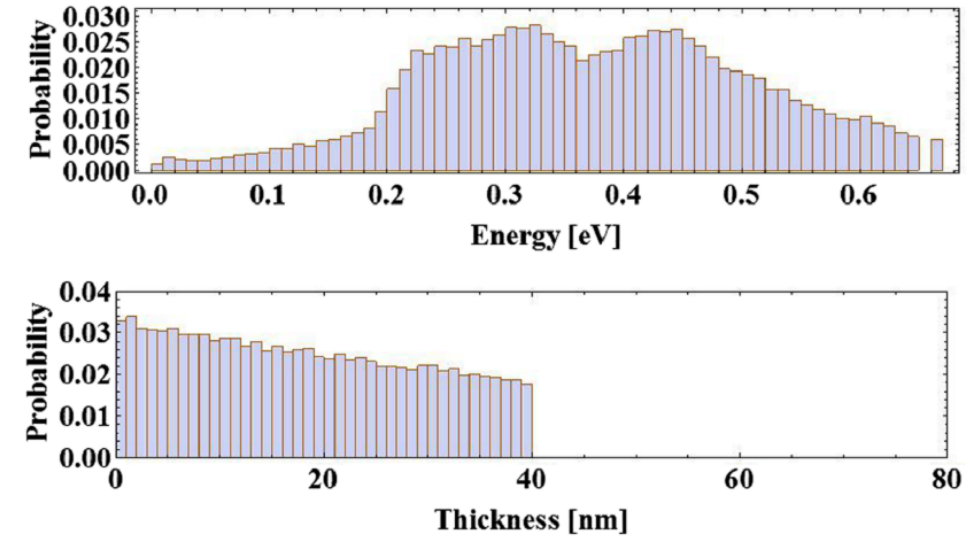
Figure 10. ( top ) The histogram of the electron-energy distribution in the conduction band excited by 2.32 eV laser photons at room temperature. The Y-axis is the probability distribution of electrons at different energies. ( bottom ) The longitudinal distribution of excited electrons along the cathode’s thickness (40 nm) with exponential decay [55].